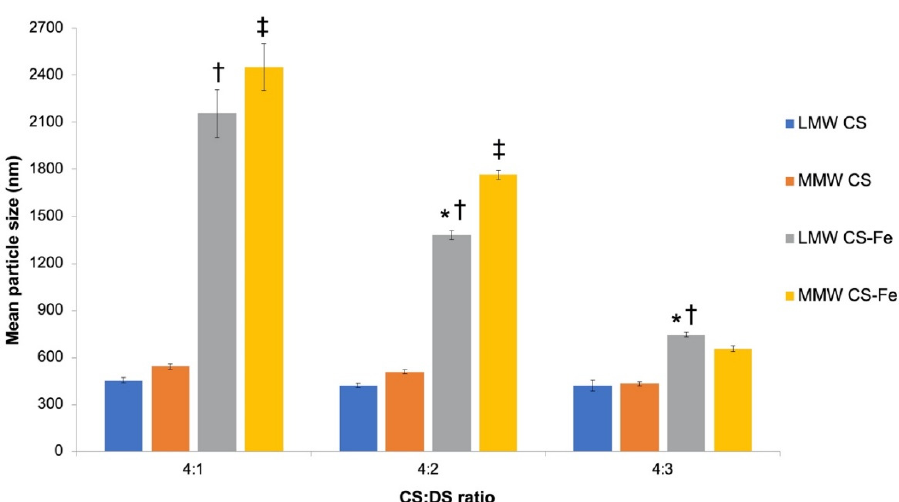
Figure 4. Effects of CS:DS ratio, iron entrapment and chitosan molecular weight on particle size. Results are shown as mean ± SD (n = 10). Data were considered statistically different when p < 0.05. * indicates sig. difference comparing 4:1 LMW CS-Fe to LMW CS-Fe at other ratios, † indicates a significant difference between LMW CS and LMW CS–Fe at the same ratio, ‡ indicates a significant difference between LMW CS-Fe and MMW CS-Fe at the same ratio.